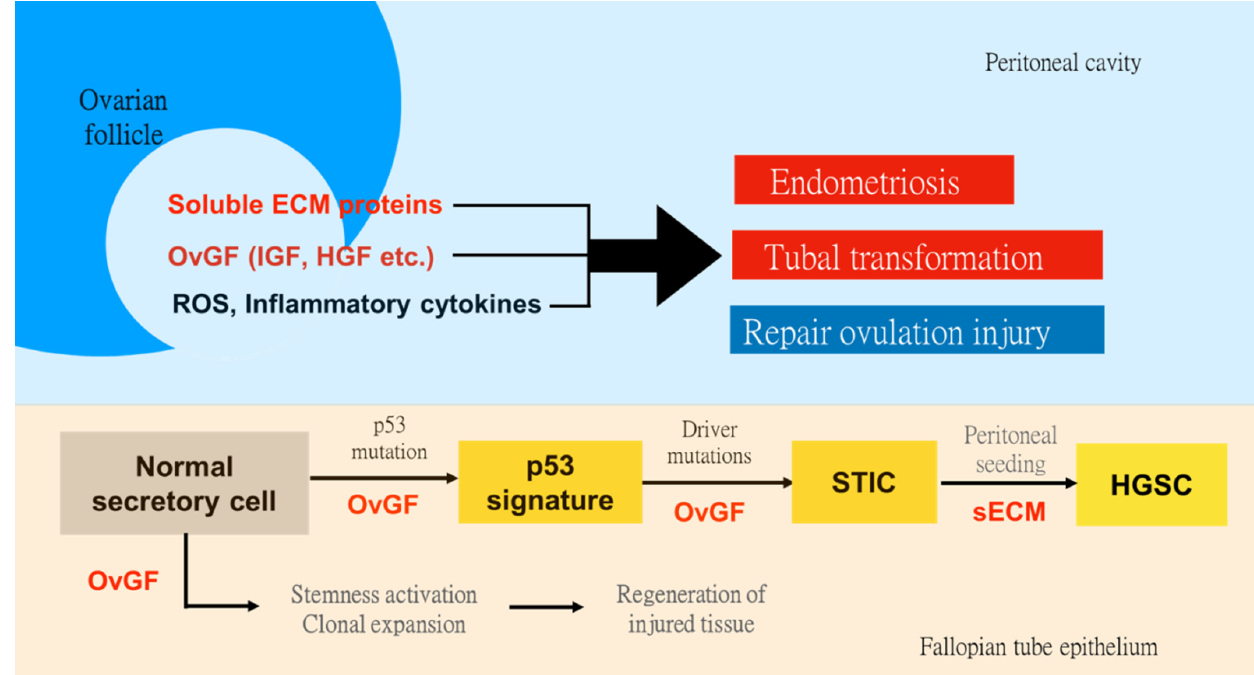
Figure 1. Growth and metastasis-promoting activities of the ovulatory follicular fluid in the peritoneal cavity that support tissue regeneration, malignant transformation, and the development of endometriosis. High levels of ROS, inflammatory cytokines, and growth factors (OvGFs), such as the IGF2 and HGF, in the ovulatory follicular fluid (FF), have been proved to be responsible for the malignant transformation of the fallopian tube fimbrial epithelium and regeneration of injured tissue caused by ovulation. ROS and inflammatory cytokines induce mutagenesis to create driver mutations; OvGFs promote clonal expansion by stemness activation and mitogenesis, and metastasis by enhancing attachment growth, migration, and invasion. Under these FF activities, the TP53 mutation-initiated epithelial lesion (p53 signature) progresses to serous tubal intraepithelial carcinoma (STIC) and metastasizes to the ovary and peritoneum to grow high-grade serous carcinoma (HGSC). The same FF activities also mediate the regeneration of post-ovulatory injuries on the ovary and fimbria. It may also be responsible for the genesis and development of endometriosis by promoting mutagenesis, stemness, survival, attachment, growth, and peritoneal spreading and invasion of retrograded endometrial cells, as well as the preexisted endometriosis cells which are samely exposed by